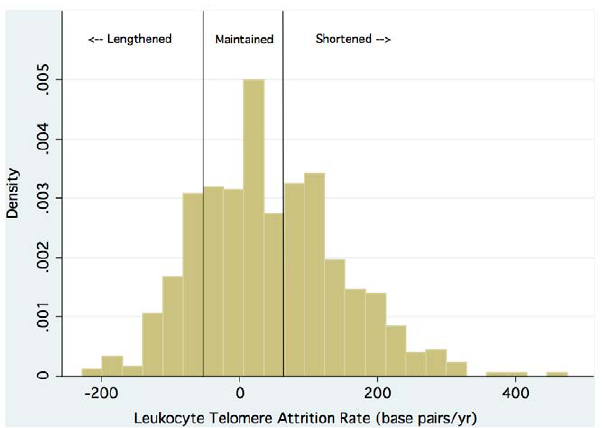
Figure 2. Distribution of leukocyte telomere attrition rate (base pairs per year).